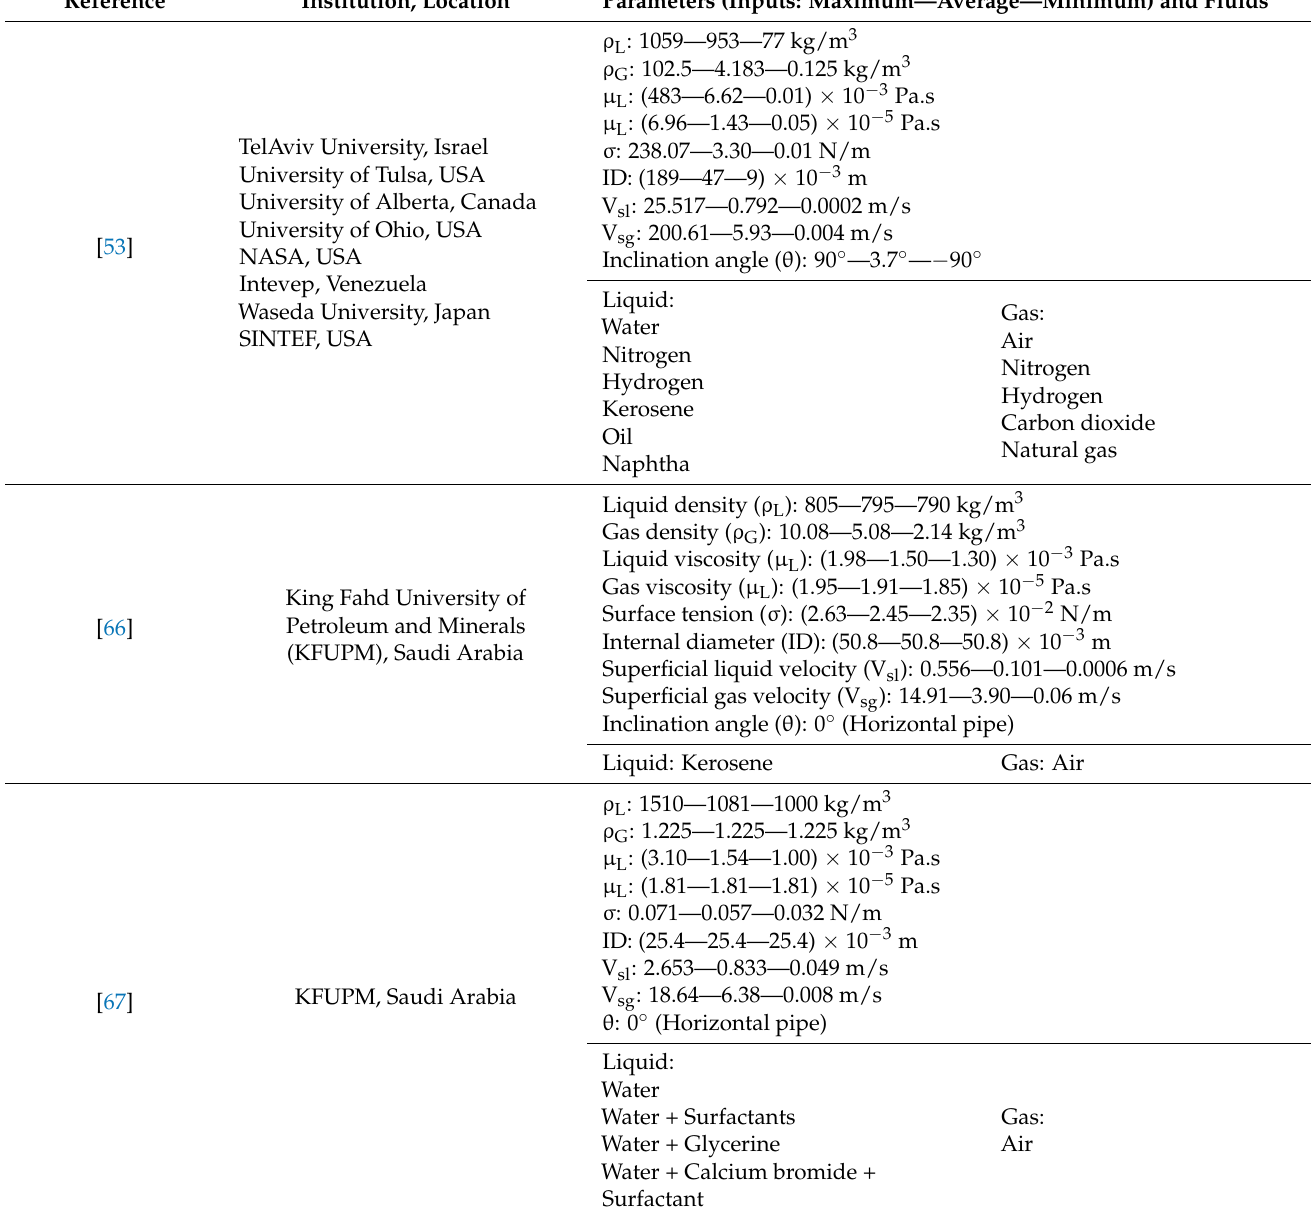
Table 2. Summary of the experiments conducted to produce the current